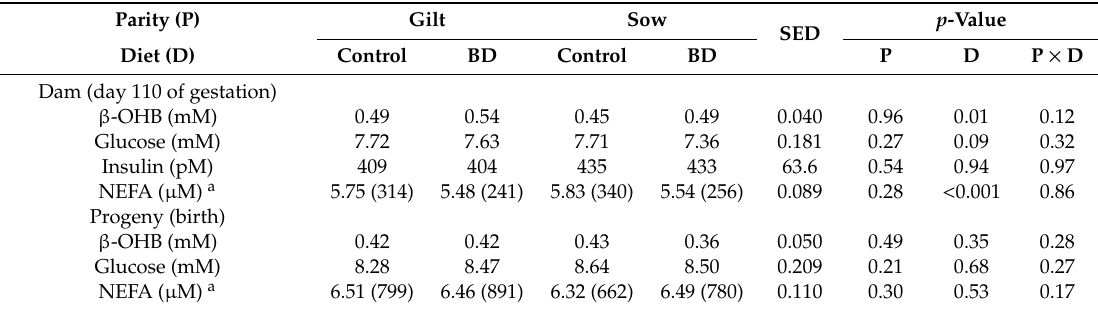
Table 4. Plasma metabolites of gilts and sows and their progeny for the Control and 1,3-Butanediol (BD)